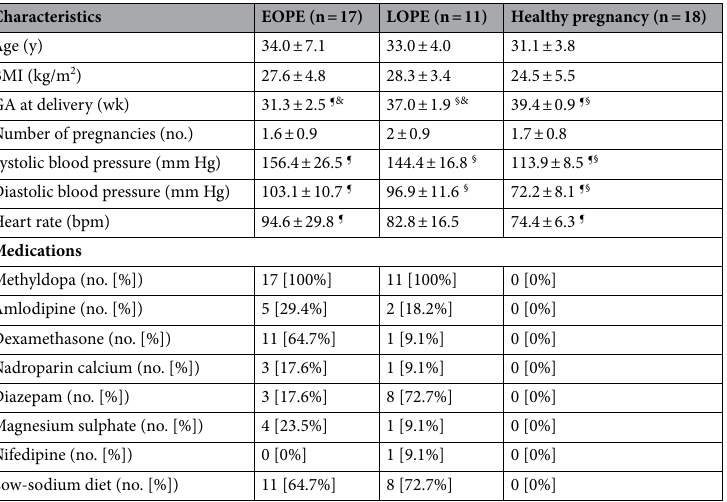
Table 1. Summary of patient characteristic (discovery/untargeted proteomics set). BMI, body mass index; bpm, beats per minute; EOPE, early-onset pre-eclampsia; GA, gestational age; LOPE, late-onset pre-eclampsia. ¶ , P < 0.05 of a characteristic between EOPE and healthy pregnancy groups. § , P < 0.05 of a characteristic between LOPE and healthy pregnancy groups. & , P < 0.05 of a characteristic between EOPE and